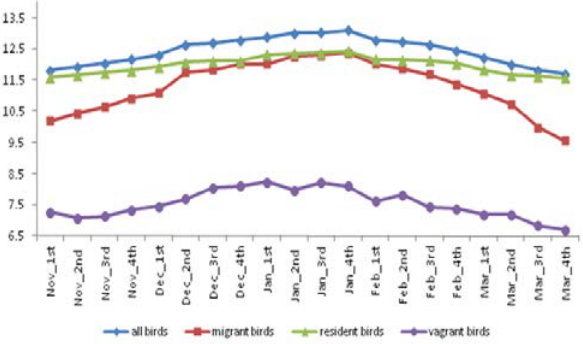
Fig. 4. Distribution of total avian population studied on all twelve wetlands. Y axis has log natural data of all individuals of all species coming under the categories. The data pertains to different winter weeks of 2010-11. Months are abbreviated to first three letters and week in ordinal